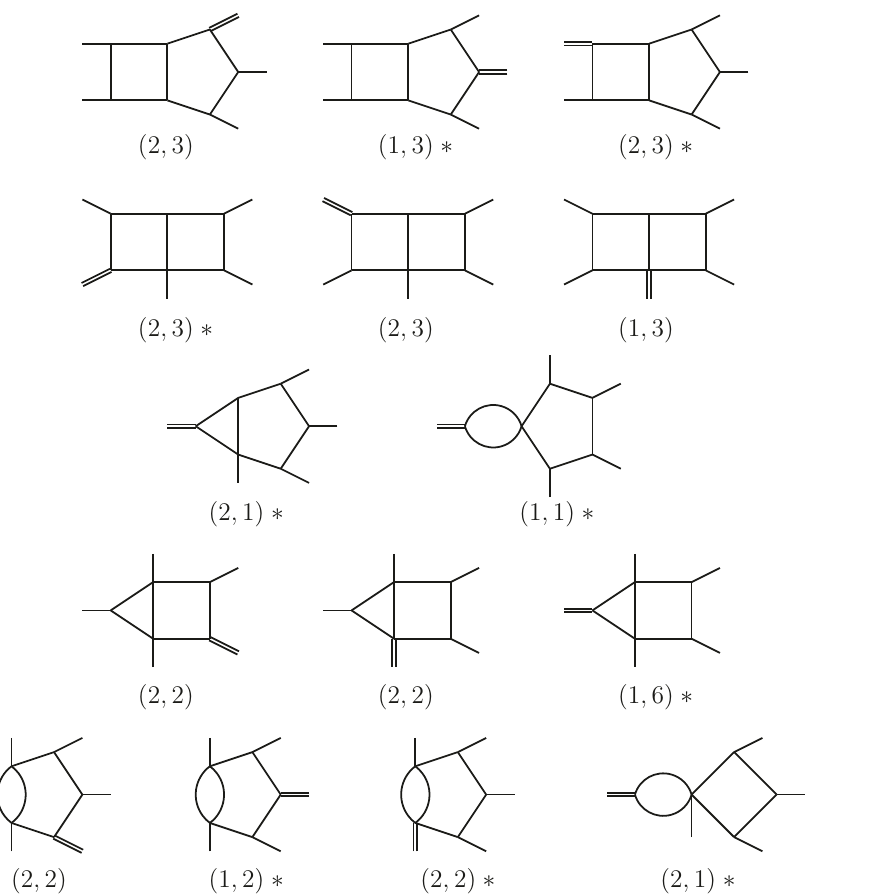
Figure 2 . Master integrals for leading colour W + 4 parton scattering at two loops with (cid:12)ve external legs. ( a; b ) represents the number of crossing of external legs ( a ) and the number master integral for a given topology ( b ). A massless (massive) external leg is indicated by a single (double) line external leg. The sign identi(cid:12)es master integral topologies that are not known analytically. (cid:3)